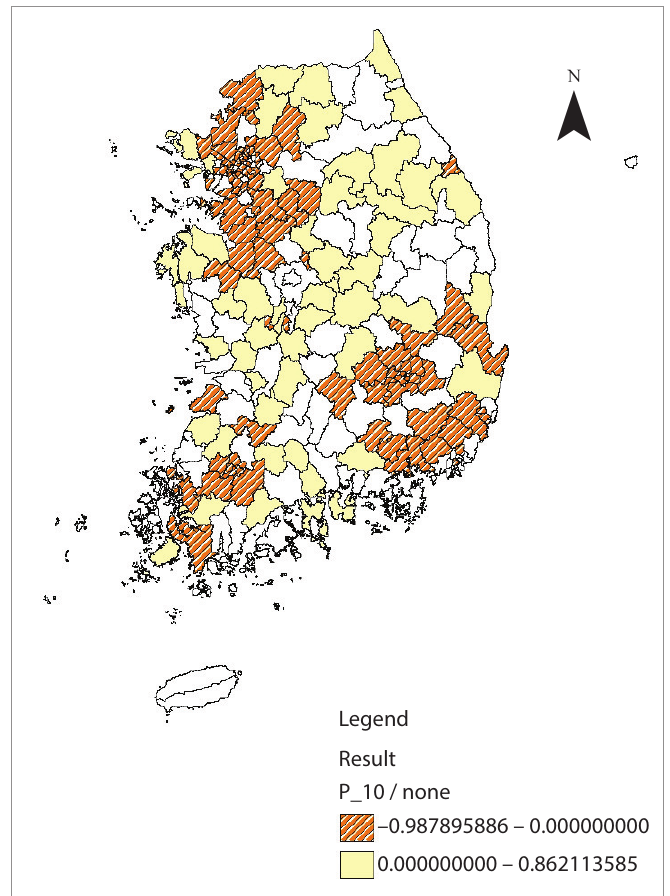
Figure 4. Result of the gap analysis between the level of heat wave adaptation policy and heat wave effects by municipality. Urban Planning, 2023, Volume 8, Issue 2, Pages